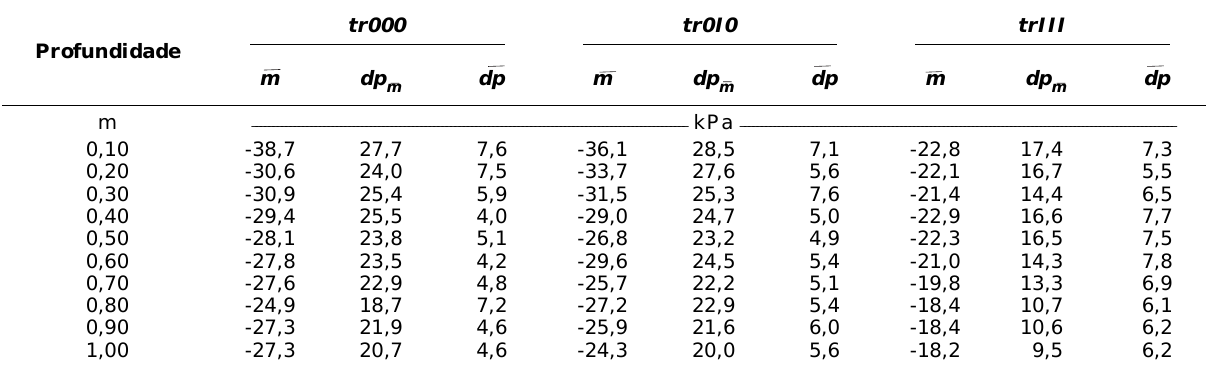
Quadro 2. Médias gerais dos potenciais mátricos para todo o ciclo ( m , calculadas a partir das médias diárias), desvios-padrões das médias diárias ( dp ) e médias dos desvios-padrões diários ( dp m